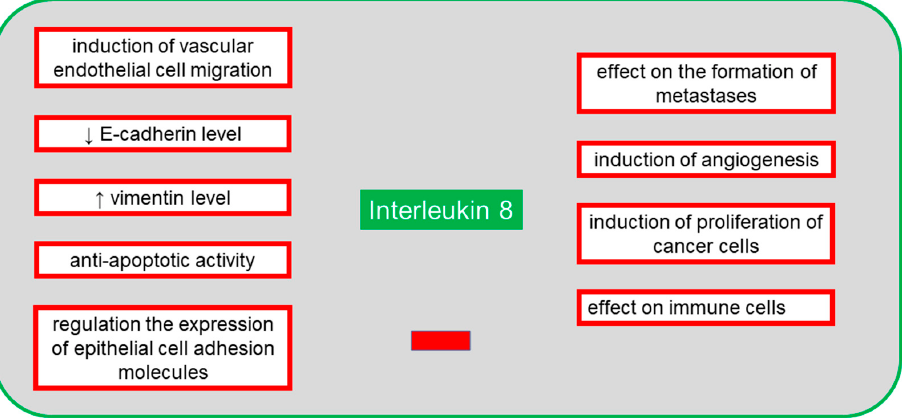
Figure 4. The negative systemic effects of interleukin 8 (IL-8) on the body in the presence of an ongoing neoplastic process.